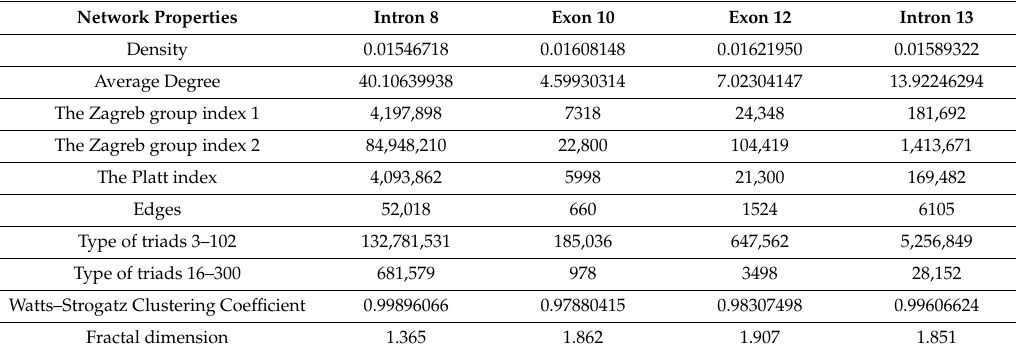
Table 2. Topological and statistical properties of the non-cancer DNA network.